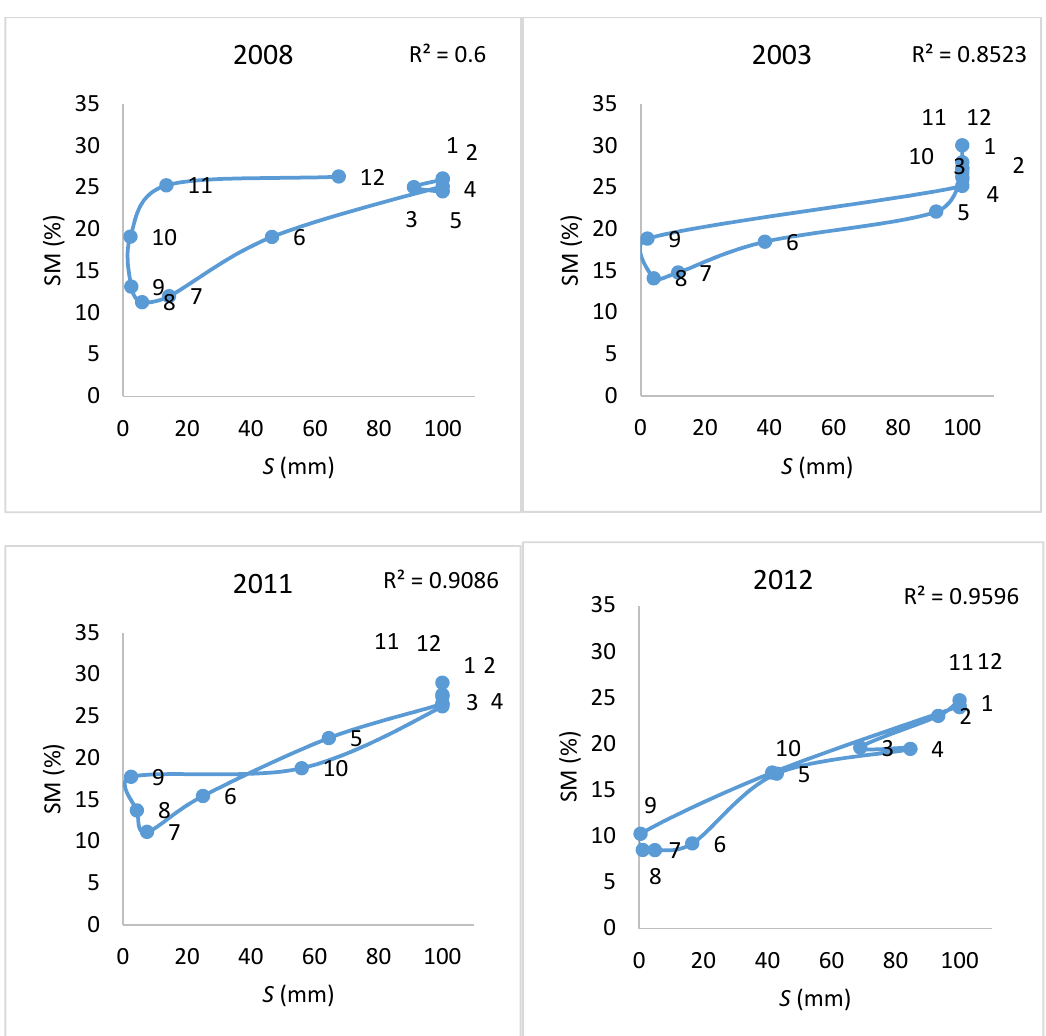
Figure 8. Chronological plot of the S vs. SM relationship for selected years of the study period, ranked (months are the dot numbers and years are ranked from lower to higher determination coefficient, r 2 , of the relationship, shown as the dotted trend line).